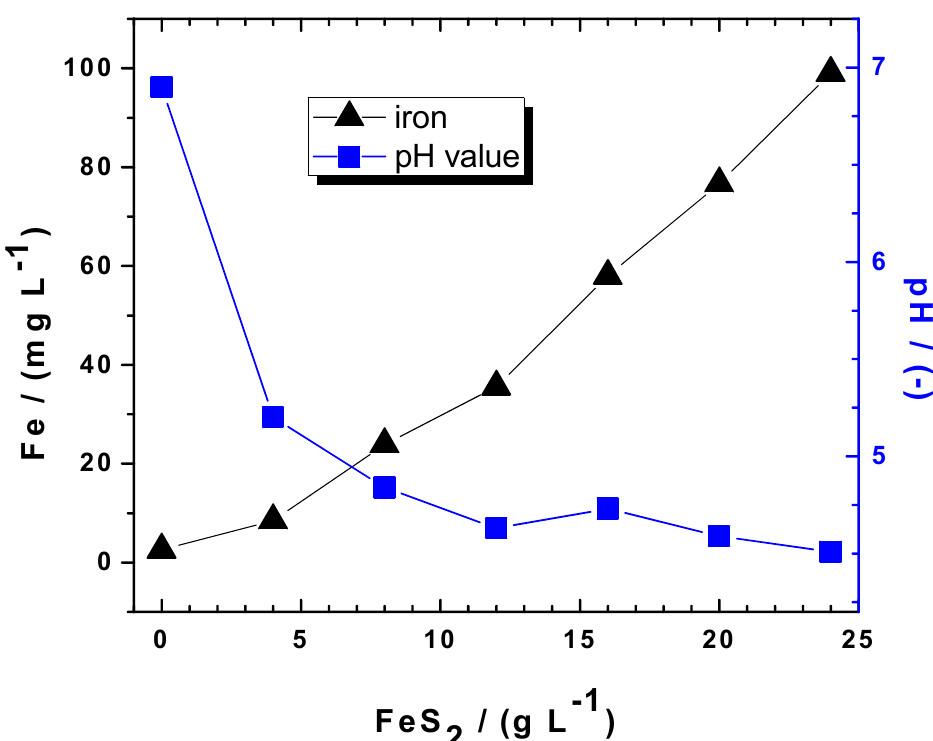
Figure 1 . Illustration of the pH shifting property of pyrite (FeS 2 ) for the Fe 0 /H 2 O system. The initial pH value is 7.0; data are from Cui (2020) [57]. The lower the FeS 2 loading, the higher the pH value. Correlating the final pH values to the extent of decontamination depends on other operational parameters, including the experimental duration. The represented lines are not fitting functions; they just join the points to facilitate visualization.